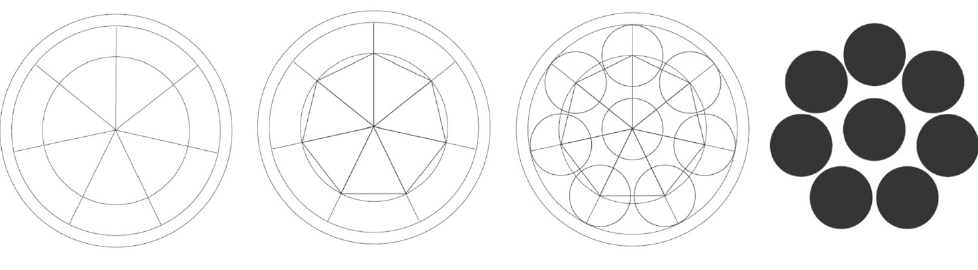
Figure 5. Proximity.